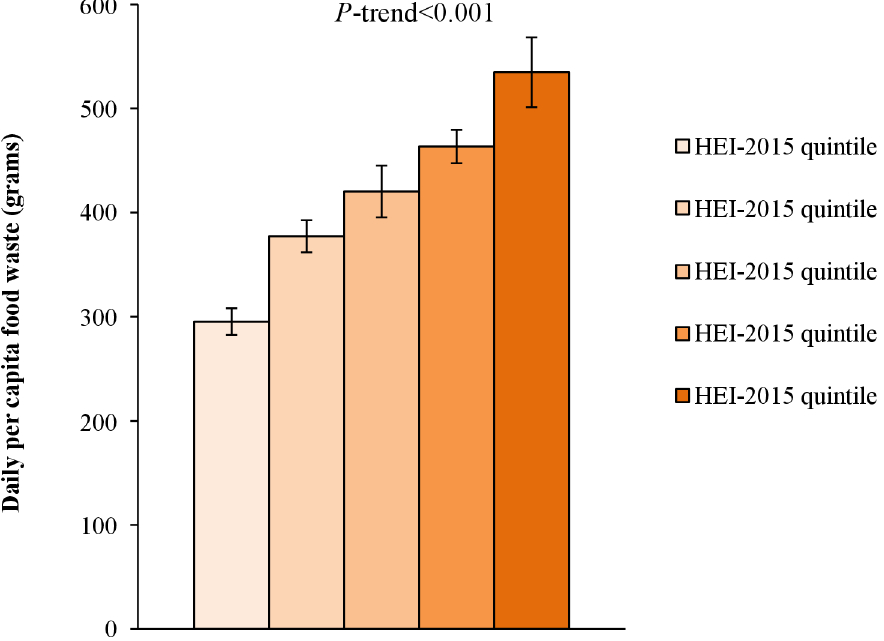
Fig 3. Total food waste by Healthy Eating Index-2015 quintile. HEI-2015, Healthy Eating Index-2015. Higher HEI- 2015 quintiles indicate higher diet quality.